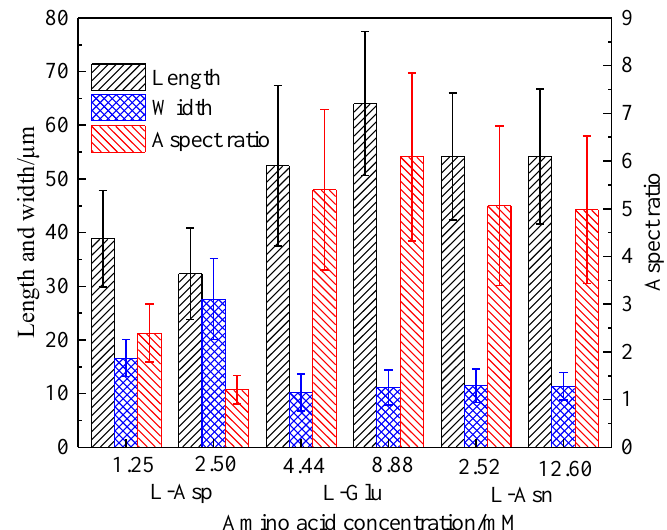
Figure 6. Effect of amino acid concentration on the crystal habit of CaSO 4 ·0.5H 2 O. ( a ) L-Asp: 1.25 mM; ( b ) L-Asp: 2.50 mM; ( c ) L-Glu: 4.44 mM; ( d ) L-Glu: 8.88 mM; ( e ) L-Asn: 2.52 mM; ( f ): L-Asn: 12.60 mM.